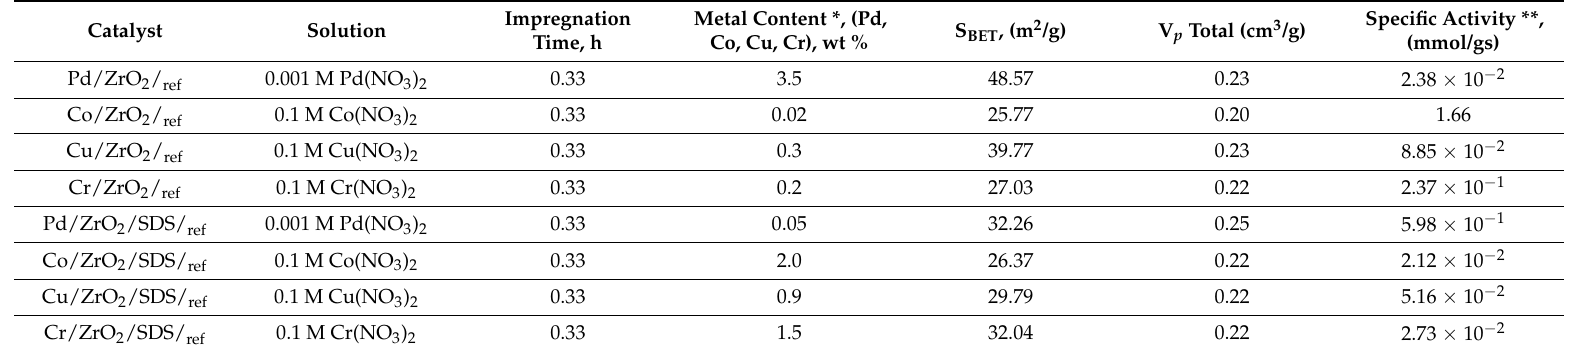
Table 2. Results of physicochemical characterisation of reference catalysts prepared via the incipient wetness method.